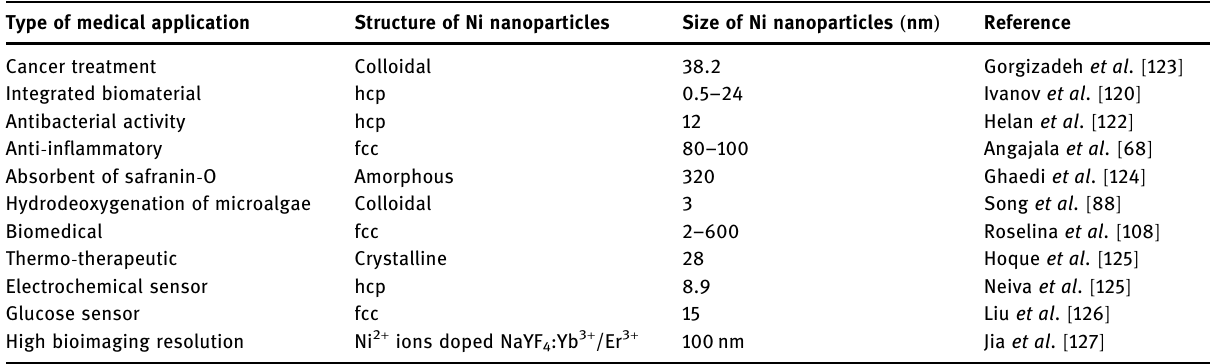
Table 5: Biomedical applications of Ni nanoparticles Type of medical